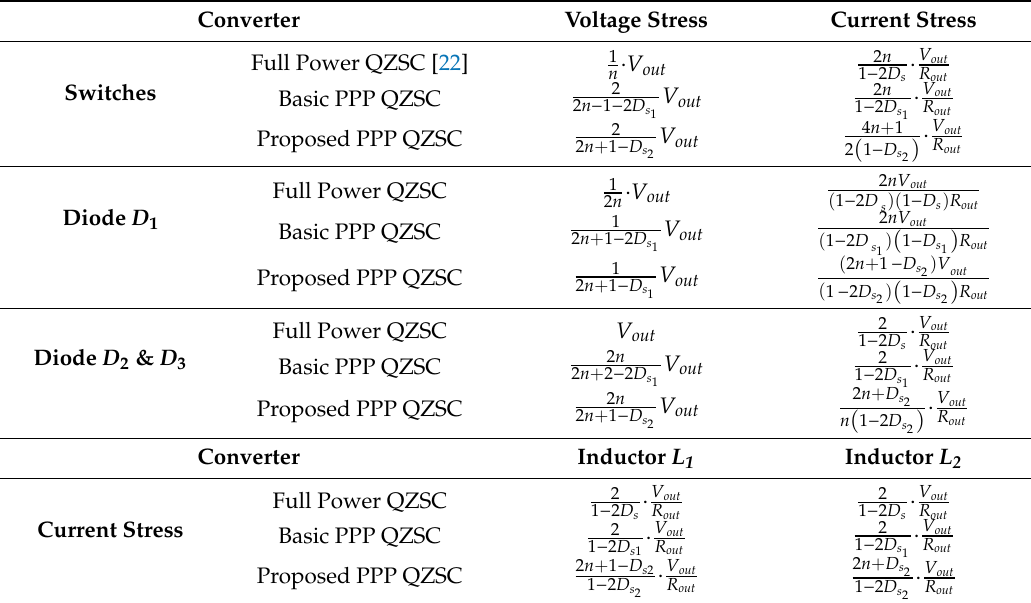
Table 1. Voltage and current stress comparison.